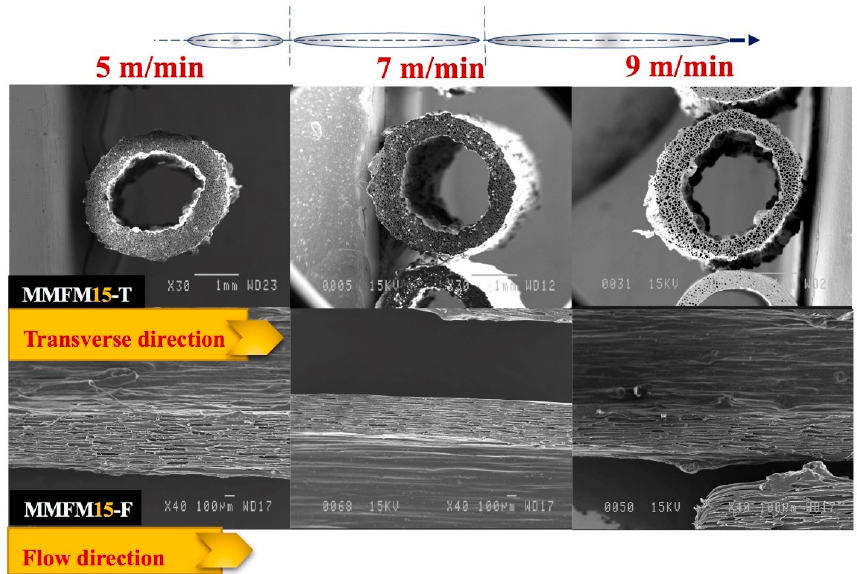
Figure 9. Micrographs of MMFM15 produced at different stretching speeds (m/min) for the ( top row ) transverse (T) and ( bottom row ) flow (F) directions.